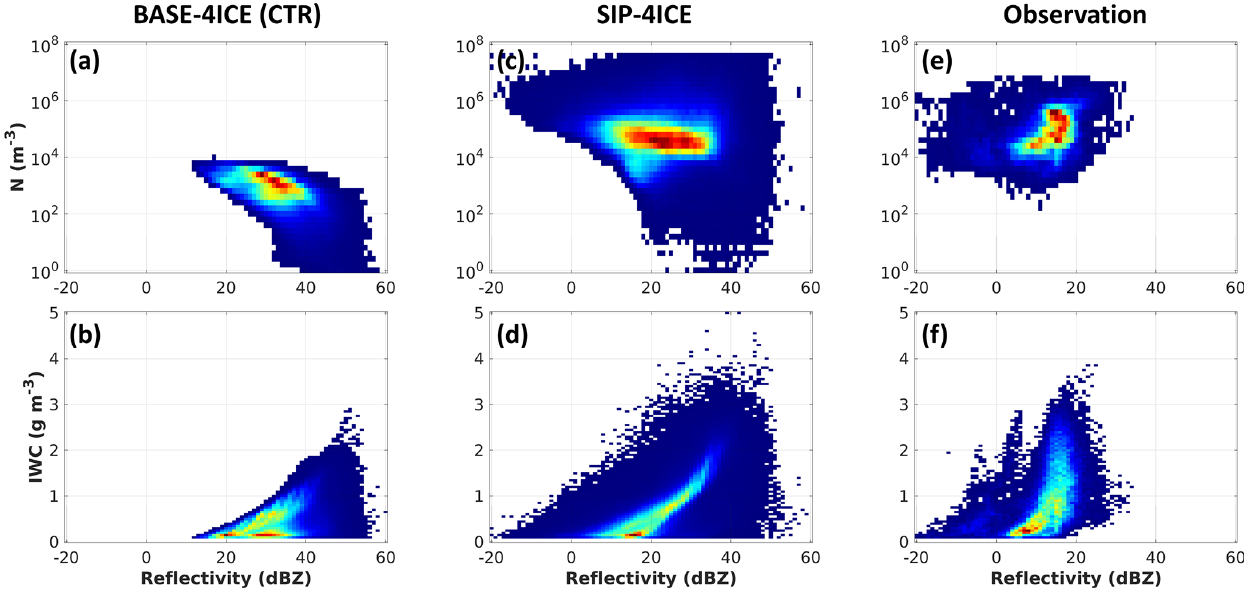
Figure 13. A 2D histogram of N i and reflectivity (a, c, e) and of IWC and reflectivity (b, d, f) . Panels (a) and (b) show BASE-4ICE (CTR), panels (c) and (d) show SIP-4ICE, and panels (e) and (f) show observations. The data between altitudes of 6 and 7km are used. For the model simulation, the data between 90 and 150min are used. The radar reflectivity data from the Convair 580 are the averaged values of the closest upward- and downward-pointing measurements.